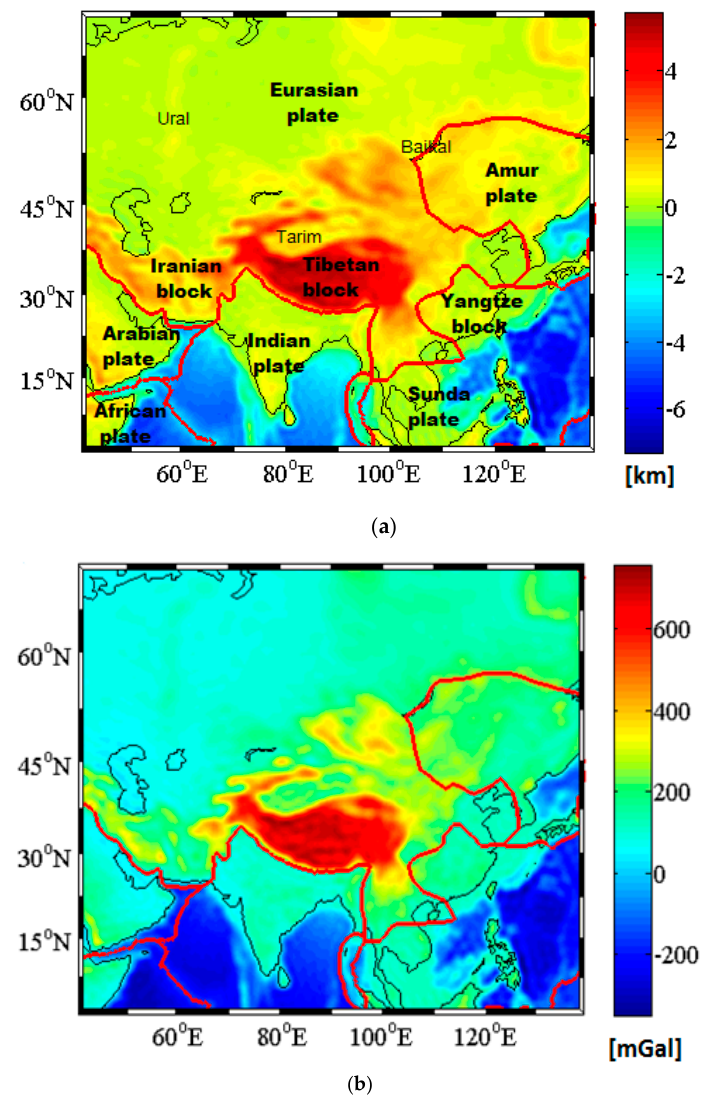
Figure 2. Regional maps of: ( a ) the solid topography and ( b ) the combined topographic-bathymetric gravitational contribution. Tectonic plate boundaries are indicated by red line.